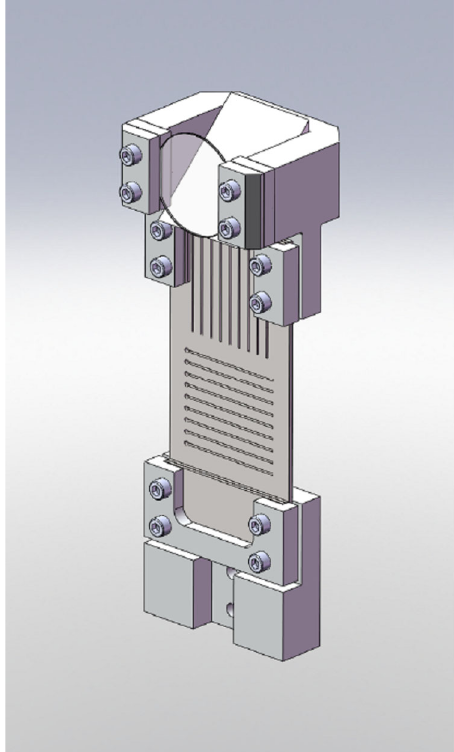
FIG. 10. Diagnostics module, showing circular YAG screen and mirror for viewing the beam transverse profile, and slits for emittance measurements. The slit plate is replaceable with blank plates for charge measurements, or with pinhole aperture